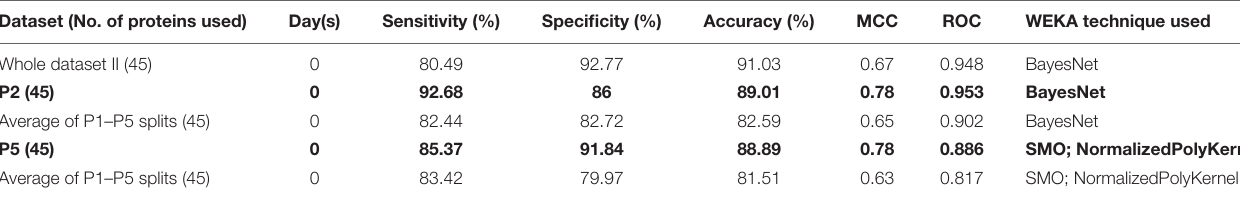
TABLE 4 | Performance of best models based on selected 45 protein NPX values. Dataset (No. of proteins